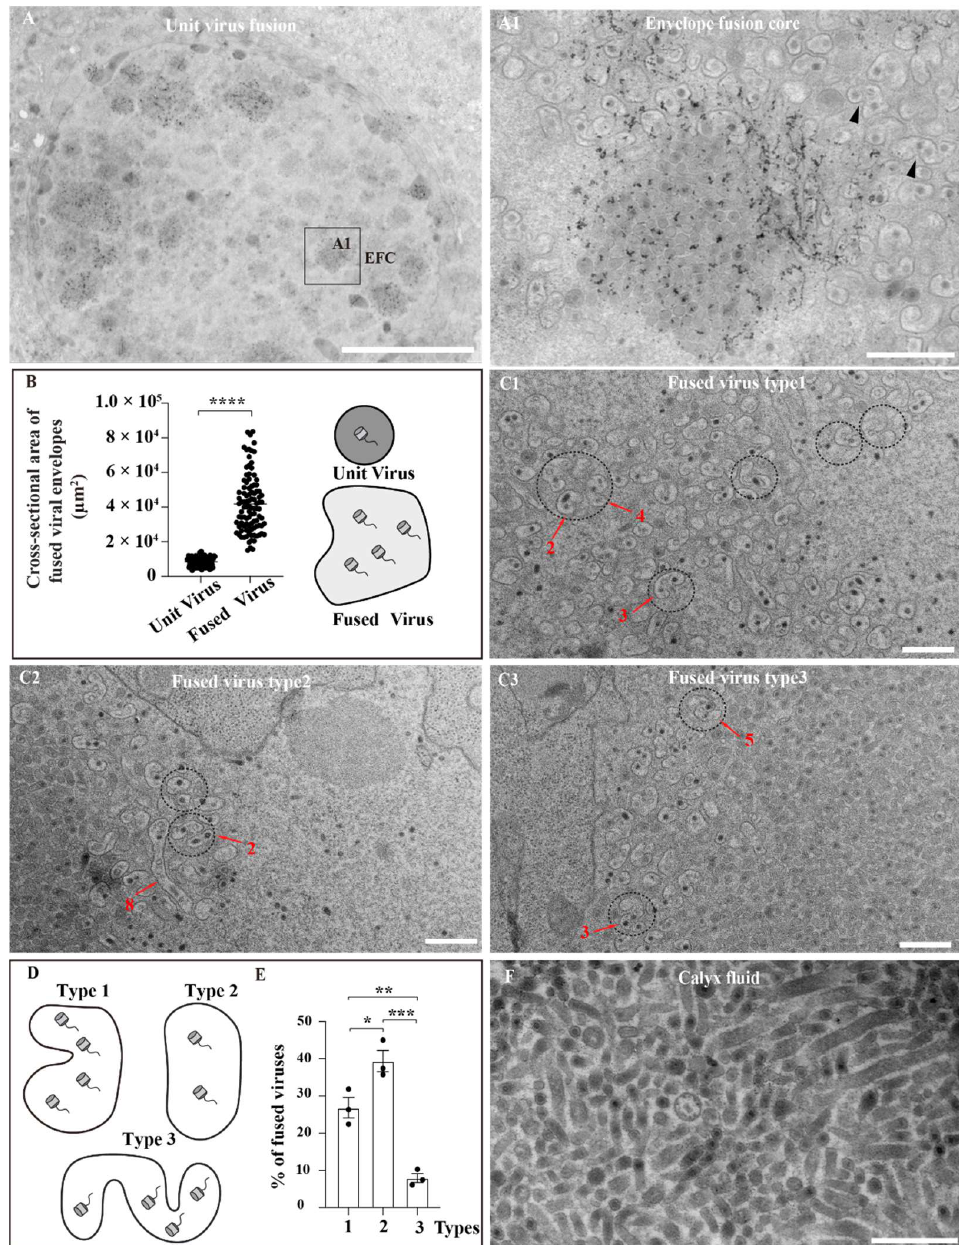
Figure 2. Envelope-fusion-syncytium formation. ( A ) Fused envelope mediated by organized struc- tures. Numerous EFCs are evenly distributed in the calyx cell nucleus. Scale bar = 5 µm; ( A1 ) EFC. The peripheral EFC is the active fused virus area. Most viruses in the central area are independent. Scale bar = 500 nm. ( B ) Unit virus and fused viral envelope cross-sectional area. **** p < 0.0001, error bars represent the SEM. Each symbol represents the nuclear area of a single viral envelope. Unpaired Student’s t -test with the Holm–Sidak method were used for multiple comparisons; n = 3. ( C1 ) Fused virus type 1 and nucleocapsids (red arrow and number). Scale bar = 500 nm. ( C2 ) Fused virus type 2 and nucleocapsids (red arrow and number). Scale bar = 500 nm. ( C3 ) Fused virus type 3 and nu- cleocapsids (red arrow and number). Scale bar = 500 nm. ( D ) Schematic illustration of the envelope- fusion-syncytium formation types. ( E ) Frequency distribution of the three main fused virus struc- tures. * p < 0.05, ** p < 0.01, *** p < 0.001. Error bars represent the SEM. Unpaired Student’s t -test with the Holm–Sidak method was used for multiple comparison; n = 3. ( F ) The mature MbBV accumu- lates in the ovary lumen. Scale bar = 500 nm.